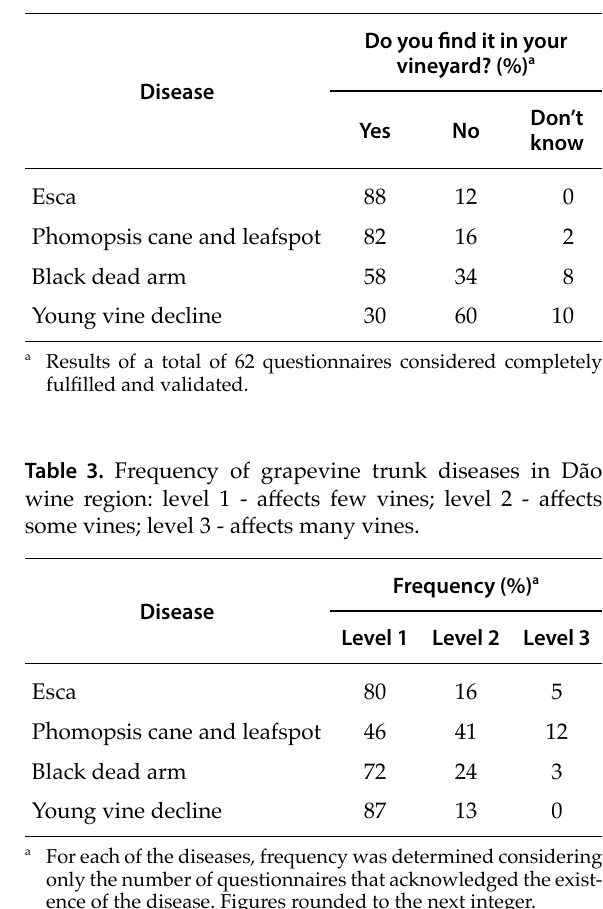
Table 2. Survey on the situation of grapevine trunk diseas - es in Dão wine region.